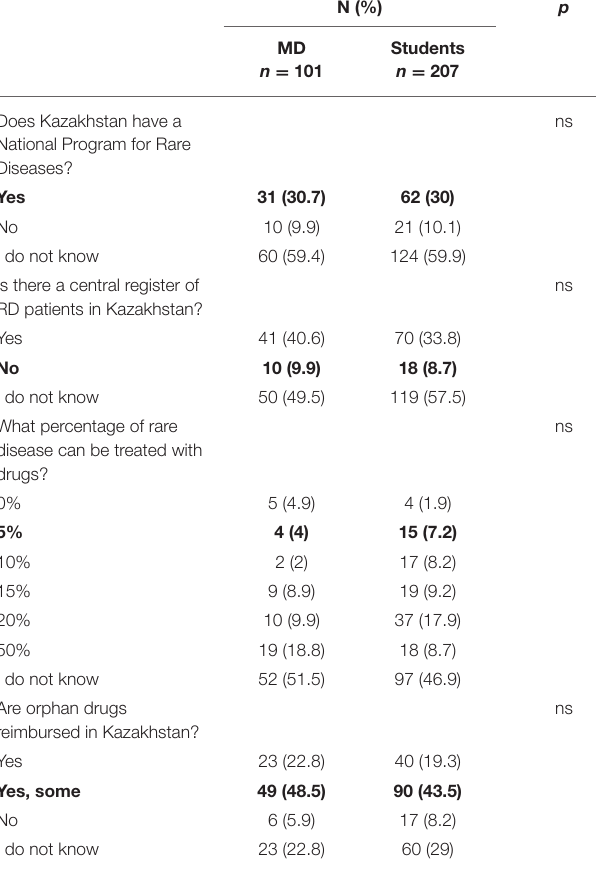
TABLE 5 | Respondents’ self-assessment of their knowledge about